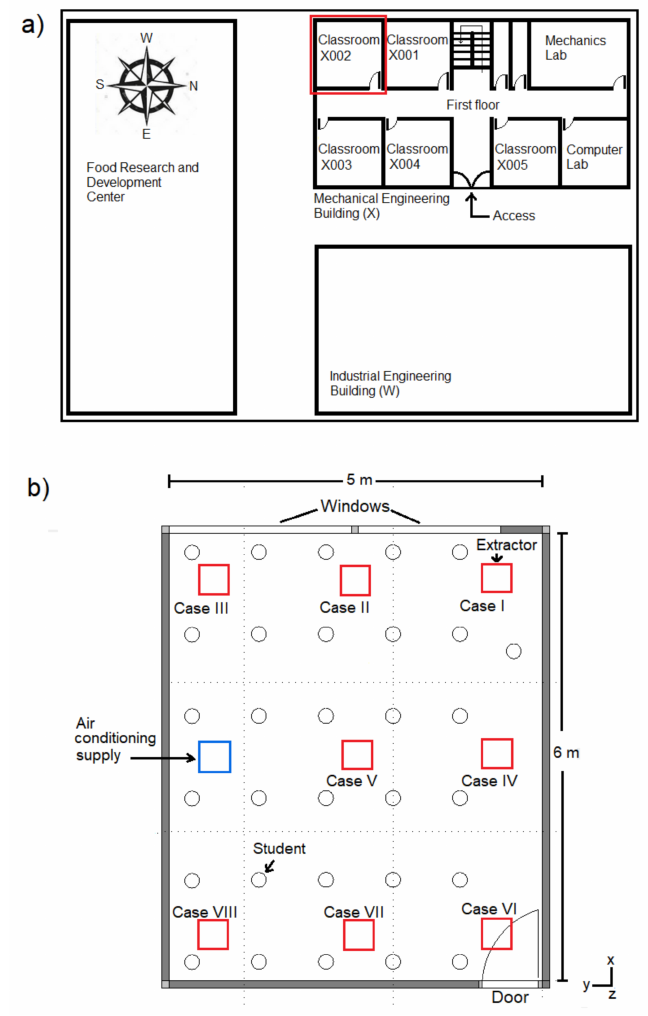
Figure 2. Plan view: ( a ) Building “X”. ( b ) Classroom “X002”. The red boxes indicate the different positions of the air extractor considered in this